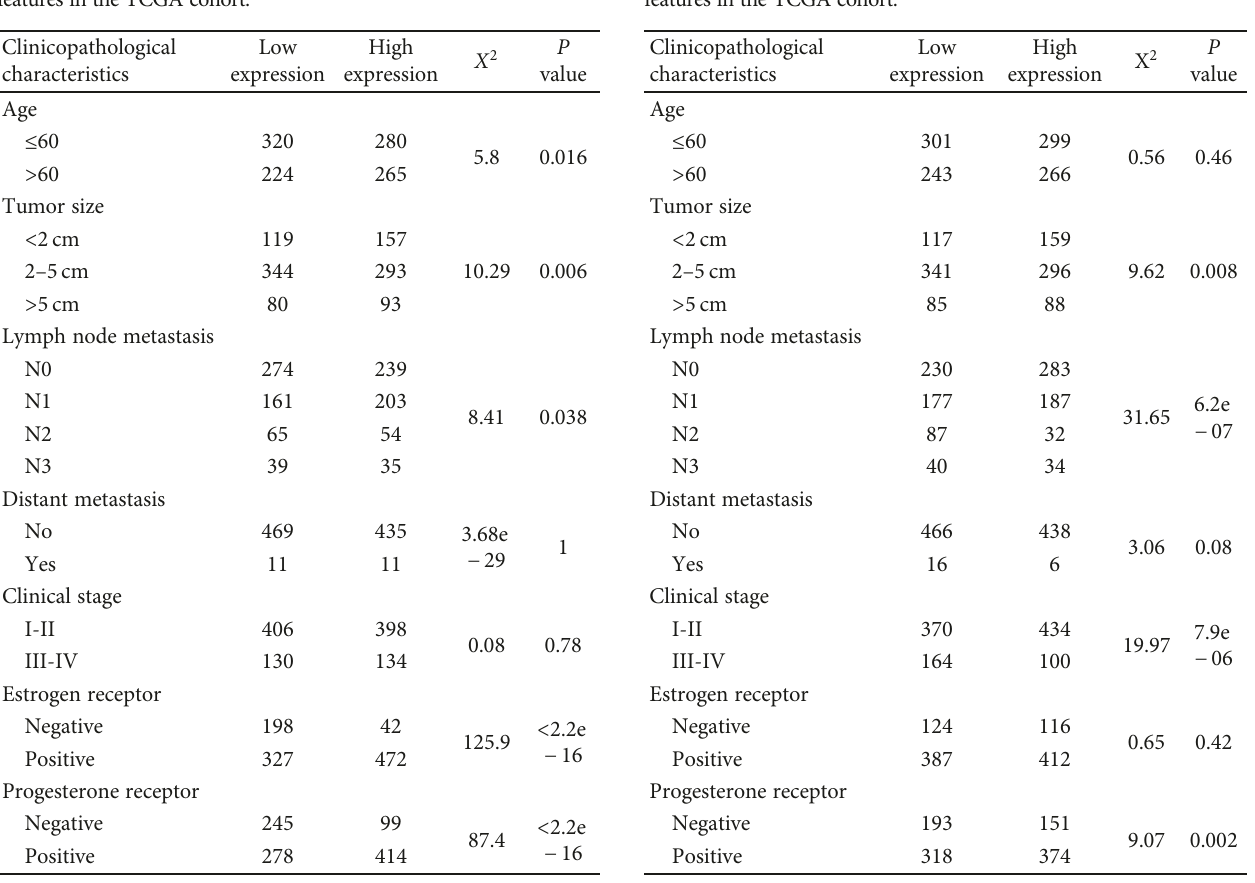
Table 2: The relationship between LPP-AS2 and clinicopathological features in the TCGA cohort.